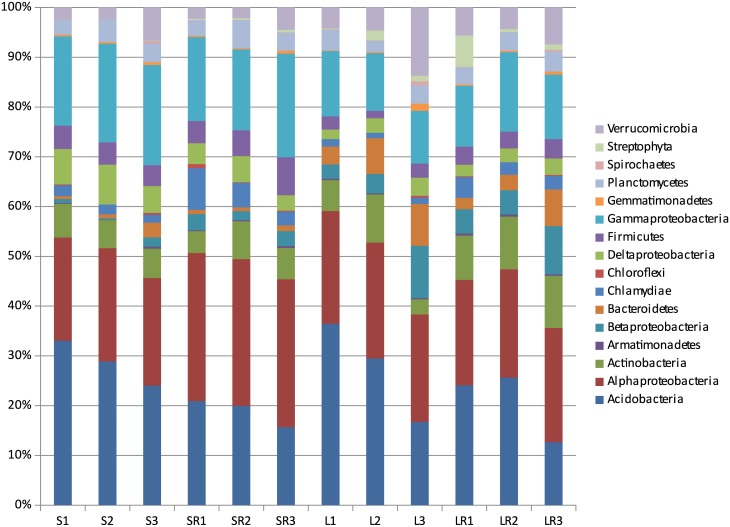
Phylogenetic composition of bacterial sequences from Picea abies forest.Samples: litter (L) and soil (S) prior to and after the recovery of bacterial communities with a saline medium (LR and SR). The data represent mean values for the three composite samples and express the estimated relative abundances of bacterial genomes.